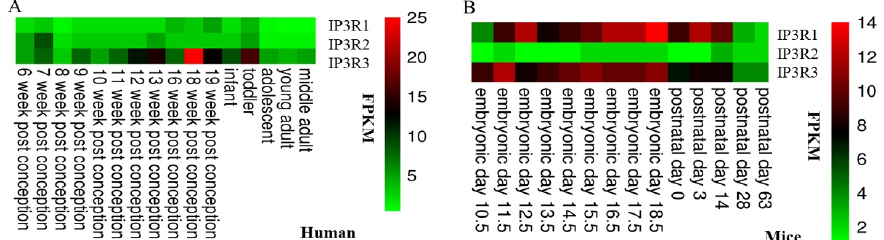
Figure 2. mRNA expression levels of inositol 1,4,5-trisphosphate receptors (IP3Rs) in human ( A ) and mouse ( B ) testes at different stages of development. The data were obtained from the ArrayExpress database (E-MTAB-6814 and E-MTAB-6798). Fragments Per Kilobase Million (FPKM) values from RNA-seq experiments were used to indicate the mRNA expression levels of IP3Rs.